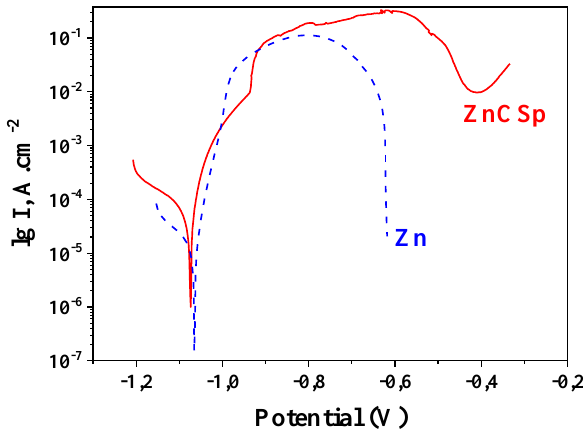
Figure 5. Potentiodynamic polarization curves of Zn and ZnCSp coatings.